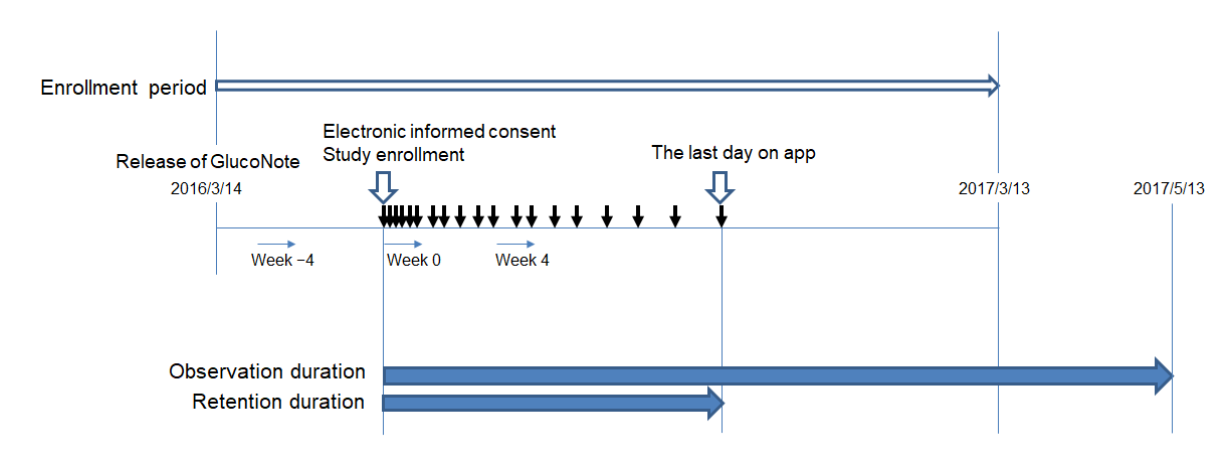
Figure 2. Definition of terms used in this